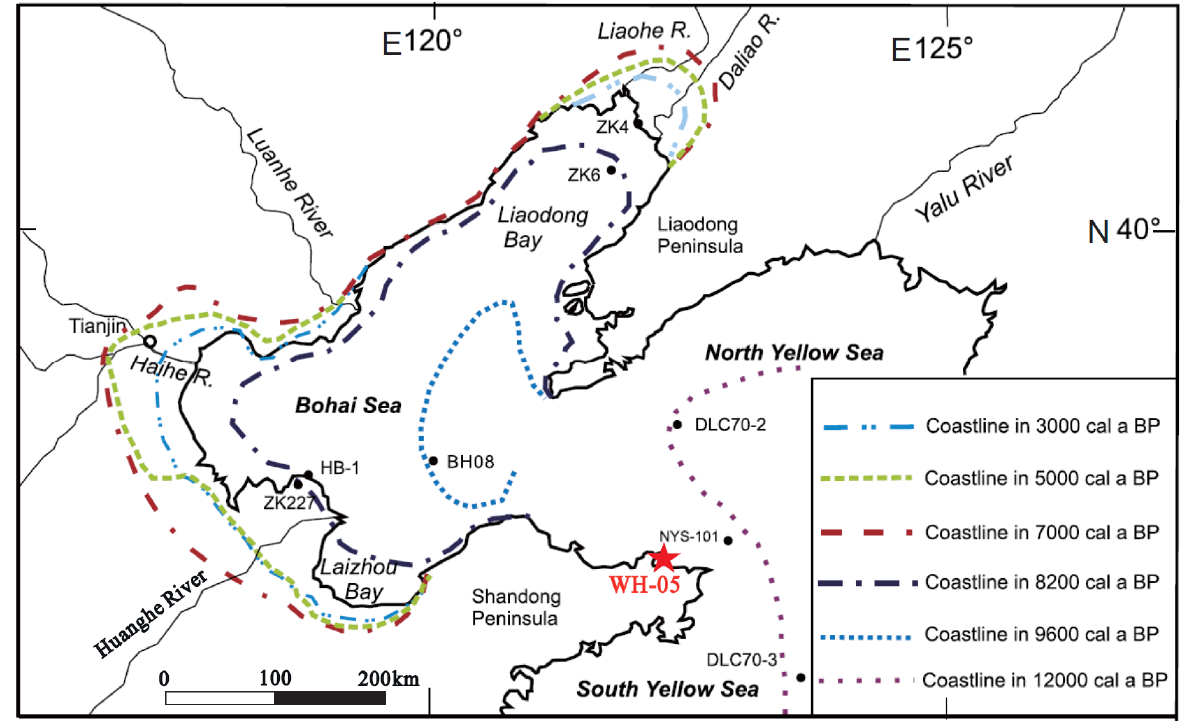
Figure 2. Location of ancient shorelines since 12 ka B.P. in the Bohai Sea and North Yellow Sea [10].